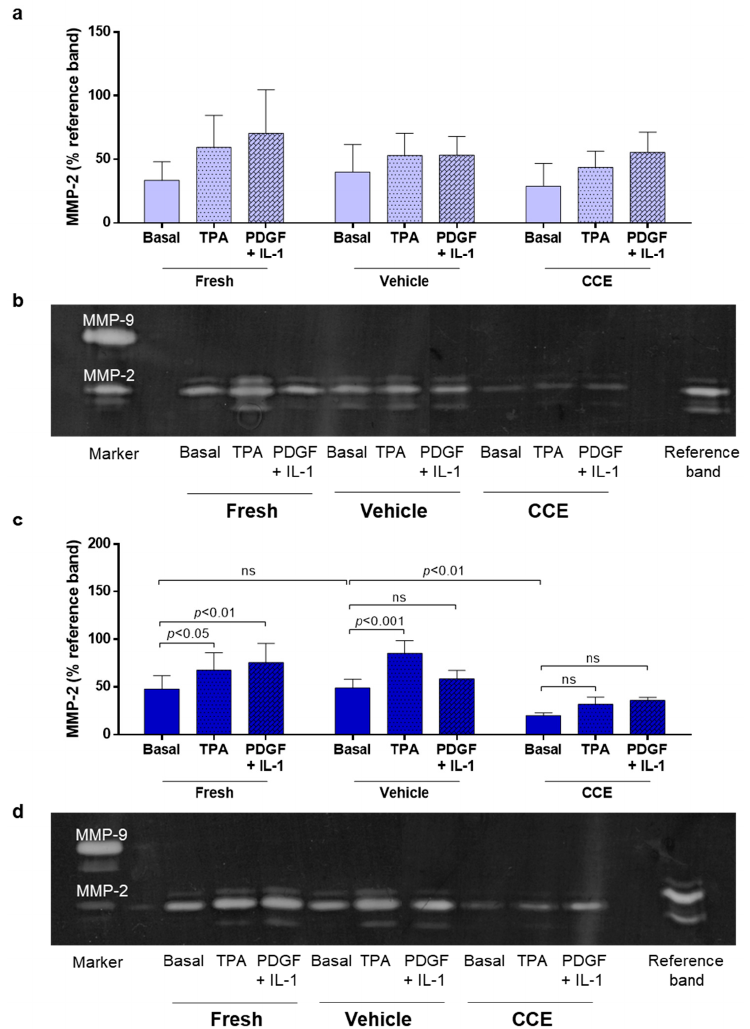
Figure 4. MMP-2 secretion from EARLY and END models. ( a ) EARLY SMC were treated with TPA (100 nM) or PDGF + IL-1 α (both 10 ng/mL) and cultured in low serum (0.4%) medium for 48 h. CM was collected and MMP-2 secretion measured using gelatin zymography. ( b ) Representative zymogram. ( c ) Parallel experiments were performed on END SMC. ( d ) Representative zymogram. All n = 3, significance assessed using repeated measures two-way ANOVA with Sidak’s multiple comparison post hoc test. ns: not